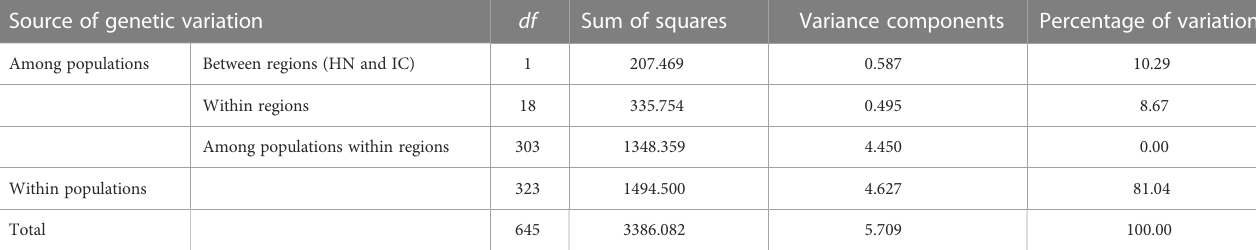
TABLE 4 Results of AMOVA analysis. Source of genetic variation df Sum of squares Variance components Percentage of variation Among